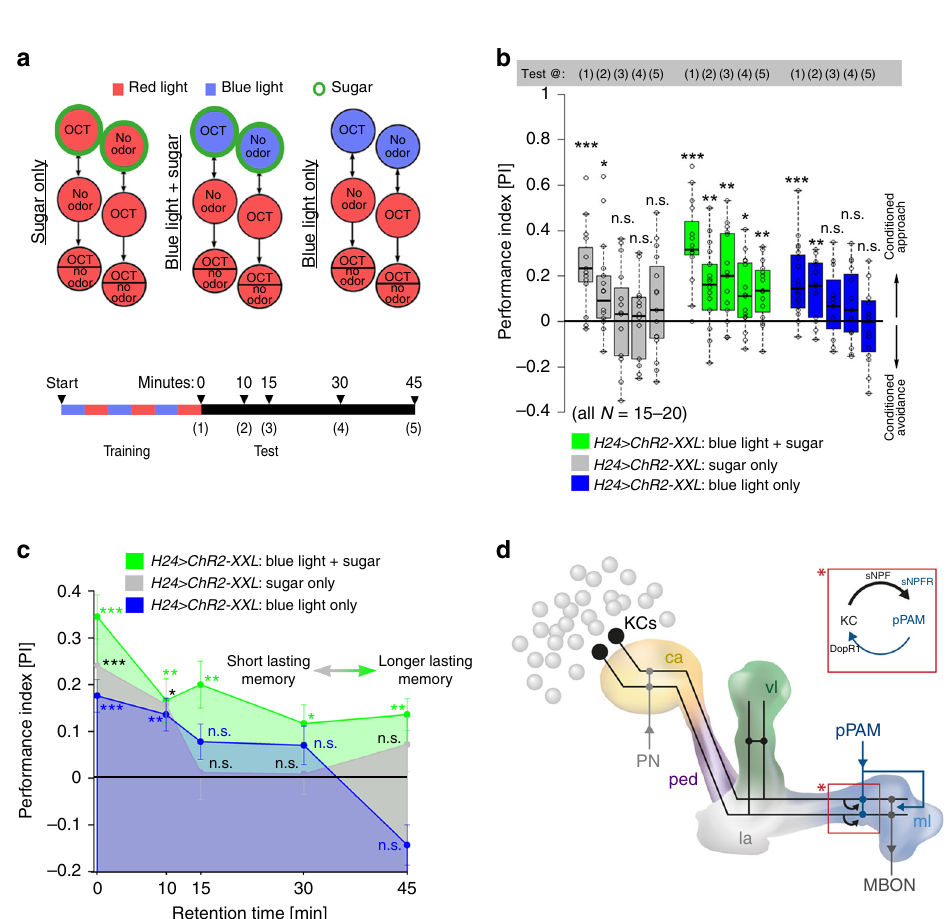
Fig. 7 KC activation during training increases memory stabilization. a Schematic drawing of the training and test regime: H24 > ChR2-XXL larvae were either trained for odor-sugar associations under red light, in the KC-substitution experiment, or for odor-sugar associations with paired arti fi cial KC activation (green circle: sugar exposure). Appetitive memory was either tested immediately after training, or 10, 15, 30, and 45 min after training. b , c H24 > ChR2-XXL larvae trained under red light ( “ sugar only ” ; gray) showed signi fi cant performance scores immediately after training as well as 10 min after training. No memory was detectable 15 min or later after training. Similarly, memory scores were abolished 15 min after training in the KC-substitution experiment ( “ blue light only ” ). H24 > ChR2-XXL larvae trained with blue light exposure and sugar stimulus during training ( “ blue light + sugar ” ) showed signi fi cant memory 45 min after training. d Schematic of the mushroom body circuit focusing on the connectivity with dopaminergic input neurons. Recurrent signaling between KCs and dopaminergic pPAM neurons exists via the sNPF receptor and dDA1 receptor (DopR1). ChR2-XXL: channelrhodopsin2-XXL; ca: calyx; DopR1: dopamine receptor 1; KCs: Kenyon cells; la: lateral appendix; MBON: mushroom body output neuron; ml: medial lobe; OCT: octanol; ped: peduncle; PN: projection neuron; sNPF: short neuropeptide F; vl: vertical lobe. A pairwise Student ’ s t test or pairwise Wilcoxon test (both including Bonferroni-Holm correction) was used. Signi fi cance levels: n.s. p > 0.05, *p < 0.05, **p < 0.01, ***p < 0.001. Error bars ( c ) represent the standard error of the mean. Data are mainly presented as box plots, with 50% of the values of a given genotype being located within the box, and whiskers represent the entire set of data. No data were excluded. Outliers are indicated as open circles. The median performance index is indicated as a thick line within the box